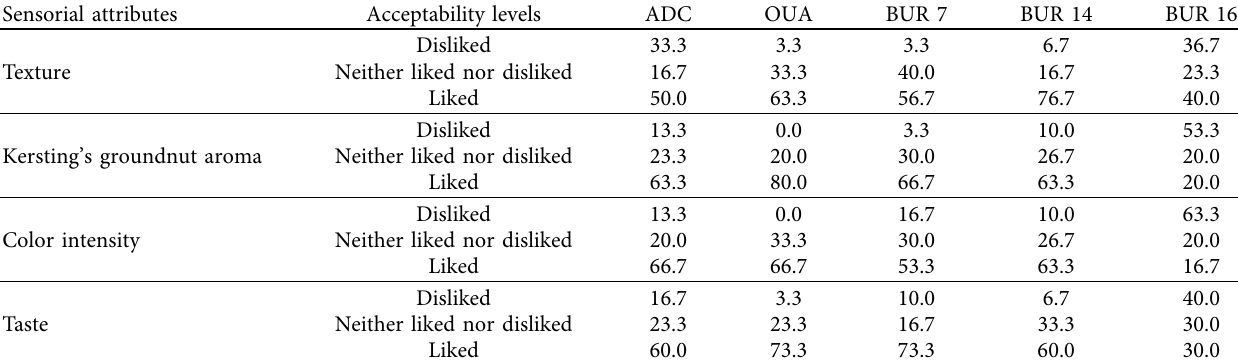
Table 7: Acceptability level of cooked Kersting’s groundnut accessions.